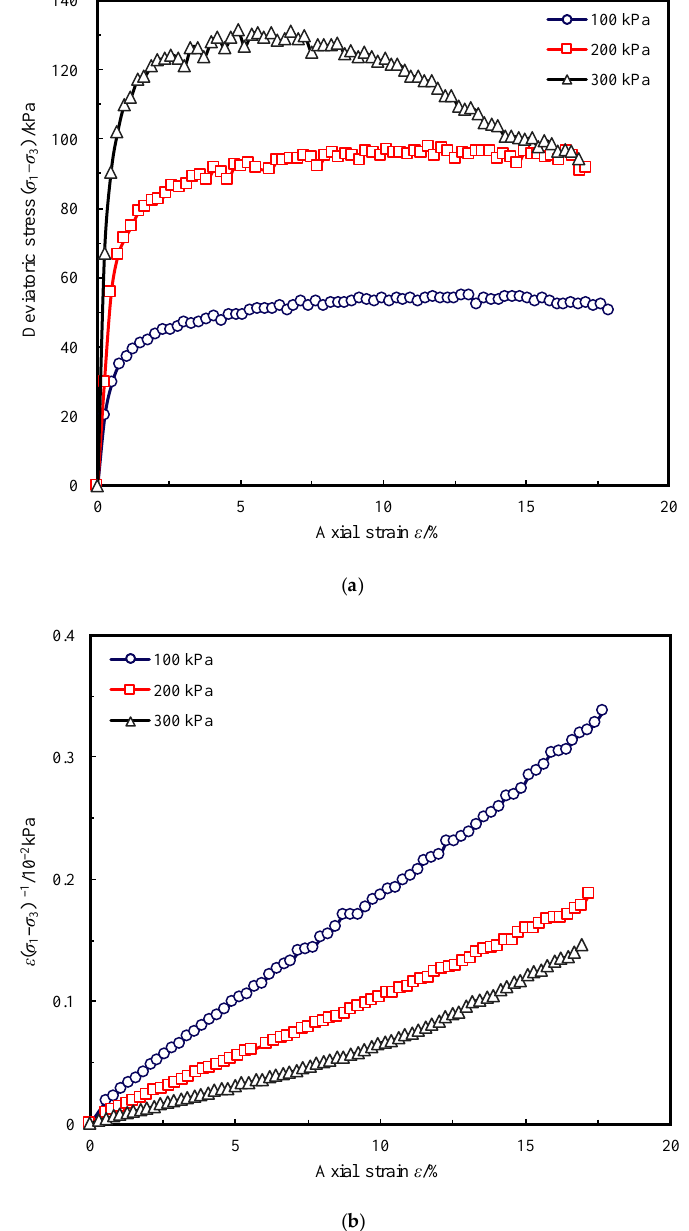
Figure 7. Stress − strain curves in CU test. ( a ) Deviatoric stress-strain behaviour; ( b ) Normalized deviator stress-strain behaviour.